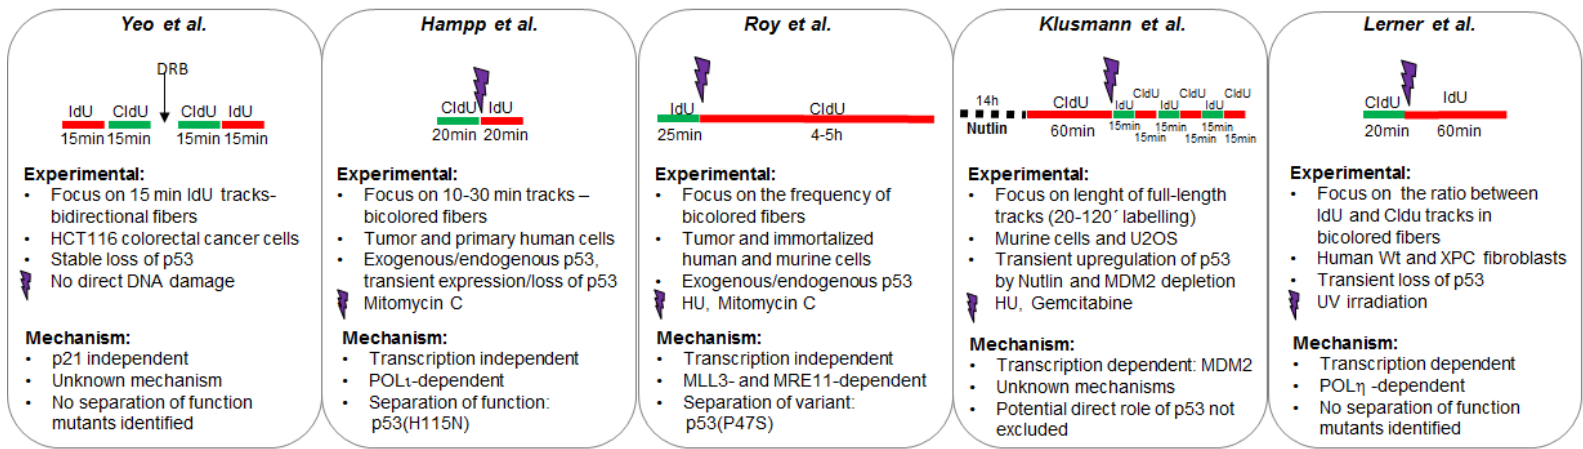
Figure 4. Different protocols used to explore the effect of p53 on DNA replication. The experimental design of each study is illustrated in the upper part of each panel. Other experimental settings are detailed in the mid-section. Mechanistic insights collected in each study are detailed in the bottom part of each panel.